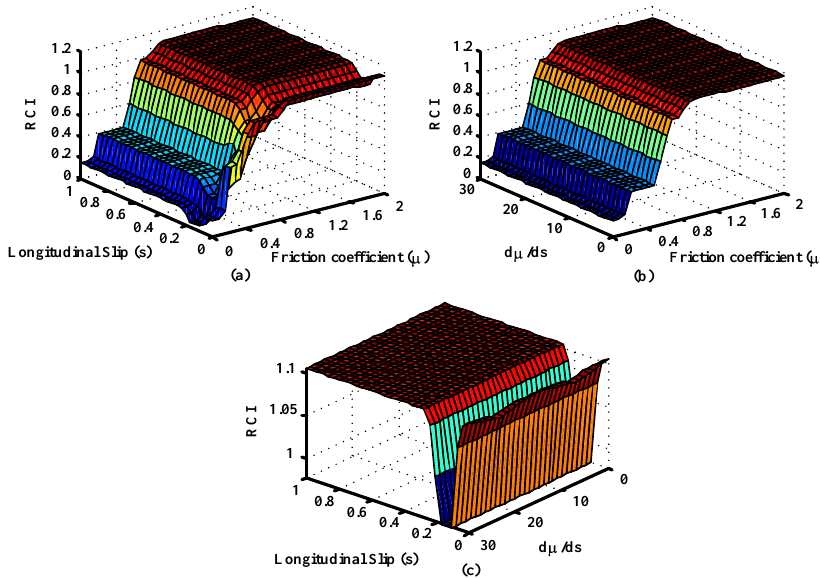
Figure 6. Membership functions of the Fuzzy Road condition estimation block.